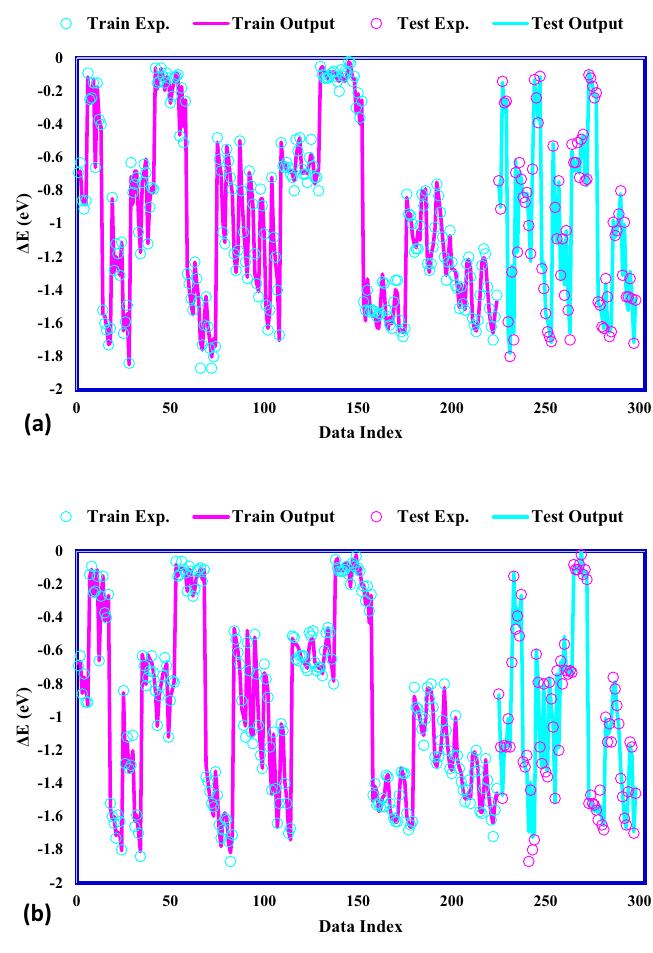
Figure 6. Comparison of actual and estimated values for ( a ) ANFIS–PSO, ( b )